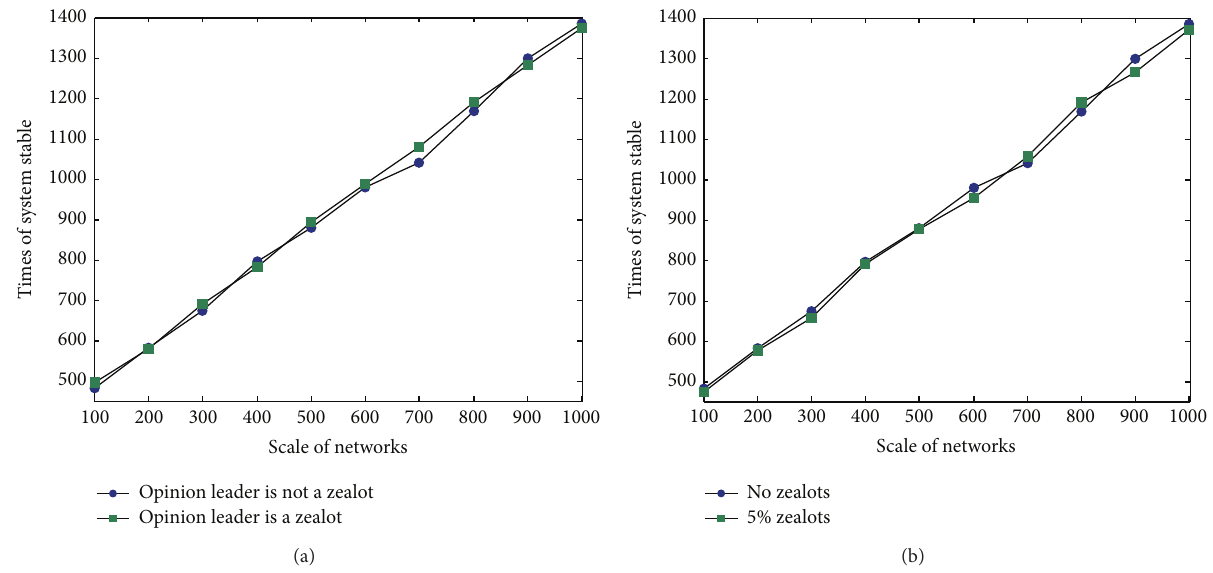
Figure 13: Influence of zealots on the times of system stable under different scale of networks. (a) It is not obviously different for promoting group consensus when the opinion leader is a zealot. (b) It is not obviously different for promoting group consensus in the case of random selection of 5% individuals as zealots. Both in (a) and (b), zealot’s opinion is 1. Each data point is an average over 30 independent experiments.